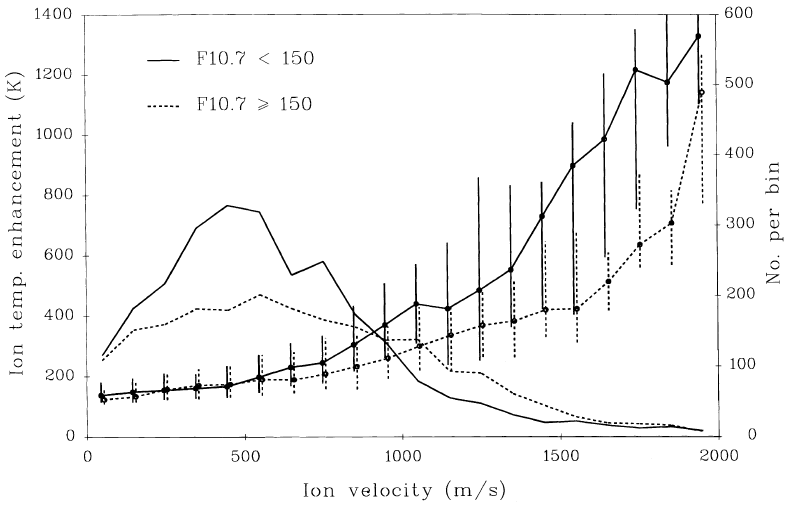
Fig. 4. Field-parallel ion temperature enhance- ment as a function of ion velocity during identified intervals of ion frictional heating. Indicated are the median enhancements in each 100 m s ) 1 width velocity bin for conditions of both high ( dotted line ) and low solar activity ( solid line ), with vertical lines which indicate the range bounded by the upper and lower quartiles. Also shown, in corresponding line styles , are the number of estimates of parallel temperature enhancement in each